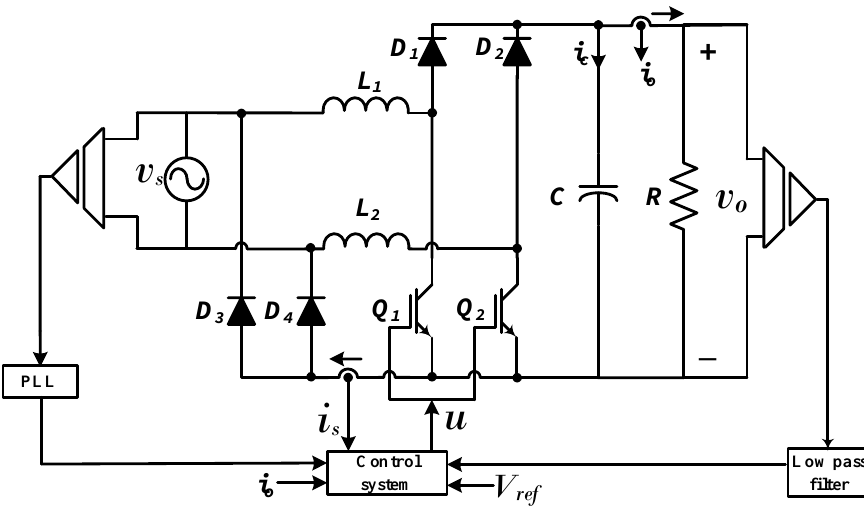
Figure 6. Control system for